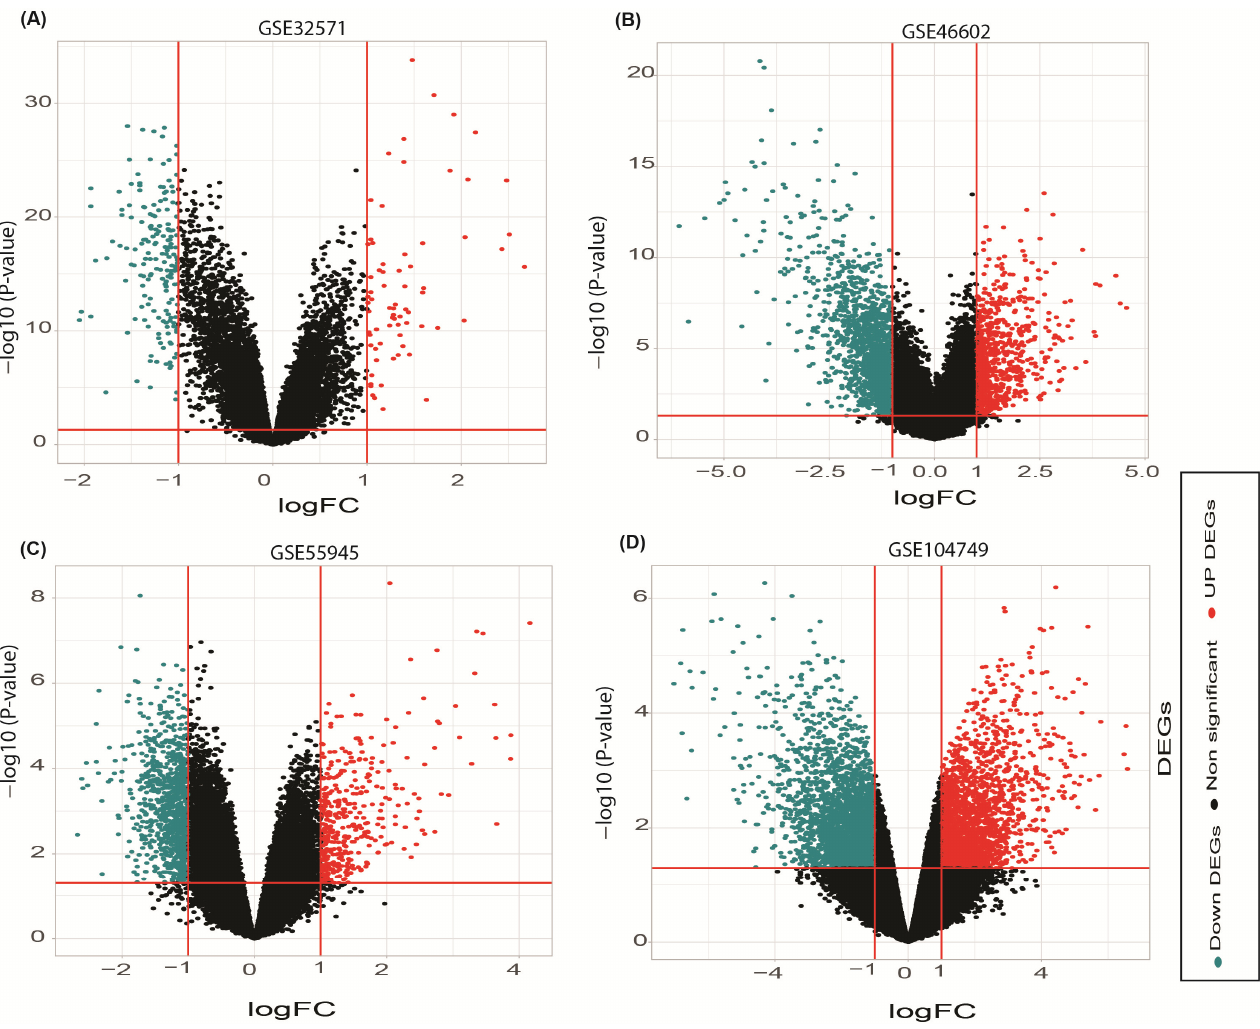
Figure 2. ( A – D ) Volcano plots showing DEGs between prostate cancer and benign prostate hyperplasia patients in GSE32571, GSE46602, GSE55945 and GSE104749 datafiles. The log2FC value > 1, log2FC value < − 1 and p < 0.05 are the cutoff value for significant upregulated (red color), non-significant (black color) and downregulated (cyan color) DEGs.